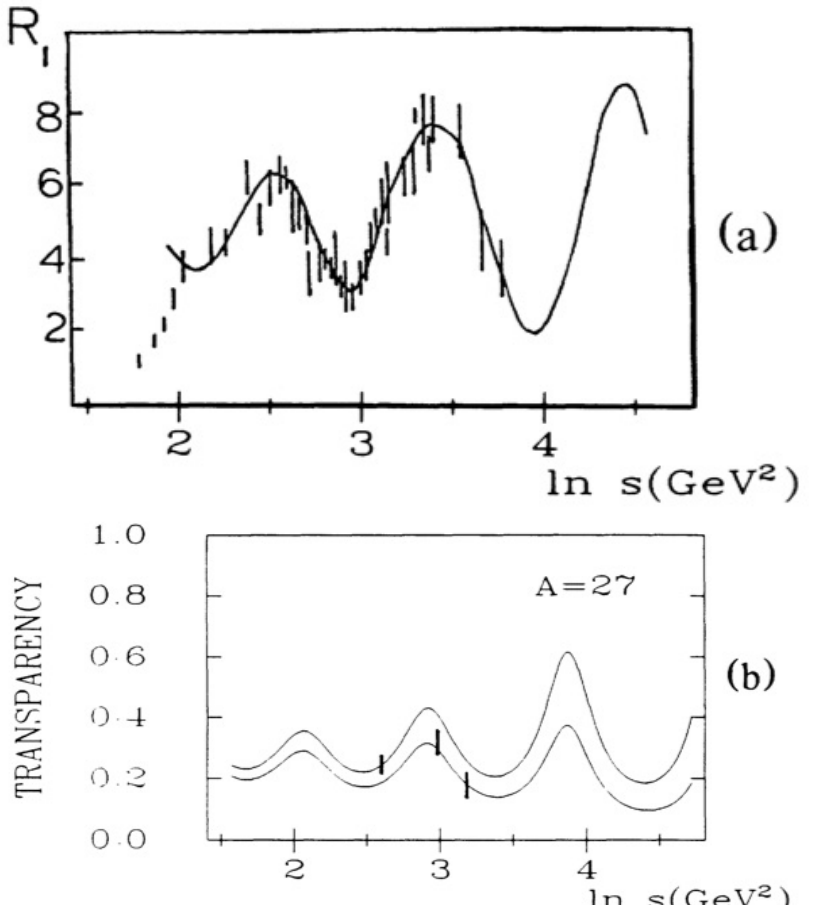
p (cid:48) p (cid:48)(cid:48) in free → p (cid:48) p (cid:48)(cid:48) ( A 1 ) ( b ), which uses this → −